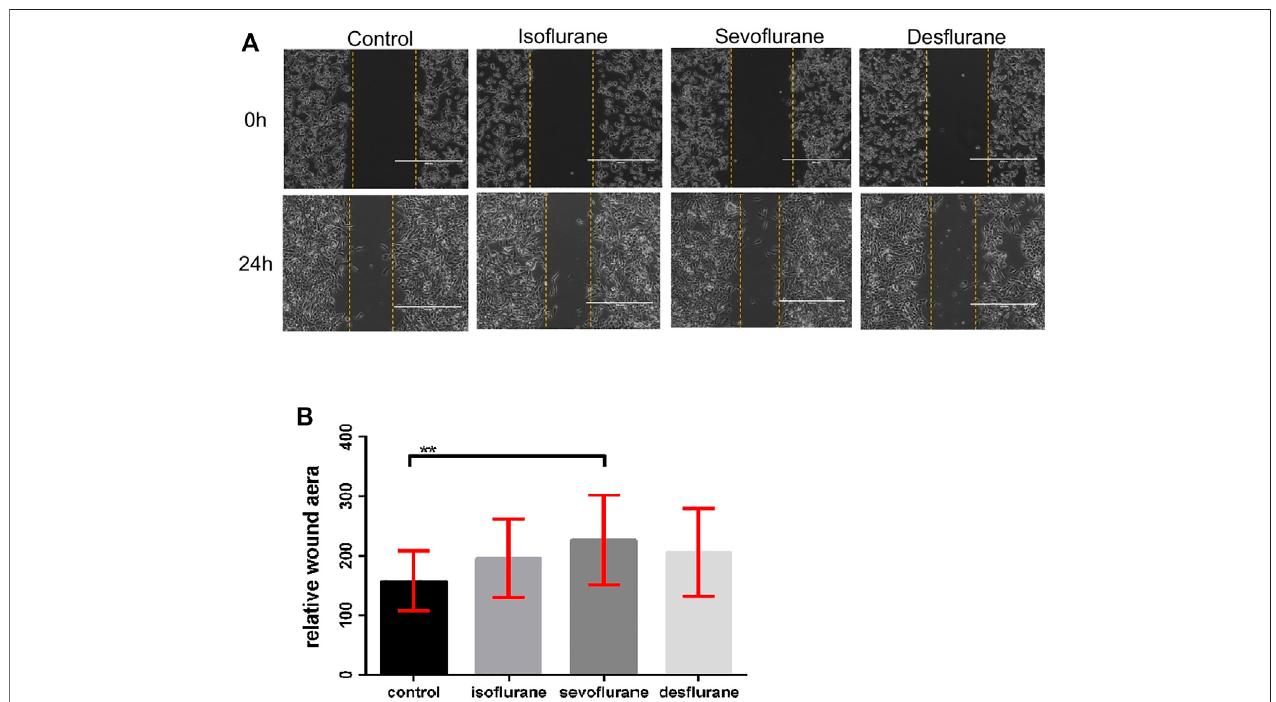
FIGURE 2 | Effect of inhaled anesthetics on the migratory capacity of 4T1 cells in vitro . (A) The 4T1 cells were wounded by a sterile pipette tip to create a cell-free path, and then they were treated with air (control), 2% iso flfl urane, 3.6% sevo flfl urane, or 10.3% des flfl urane for 3 h ( n = 18 for each group). (B) Relative wound distance was measured for statistical analysis. The differences between the control group and the sevo flfl urane group was signi fifi cant ( P = 0.024). There was no signi fifi cant difference between iso flfl urane or des flfl urane and control group. Iso flfl urane vs. control, P = 0.153; des flfl urane vs. control, P = 0.465; one-way ANOVA + Tukey ’ s multiple comparisons